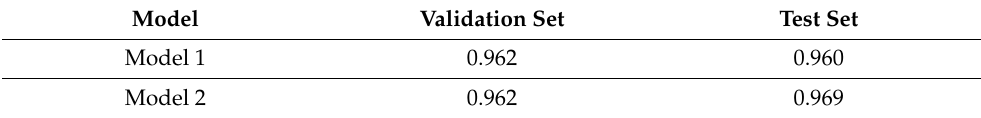
Table 3. The accuracy of the two models.